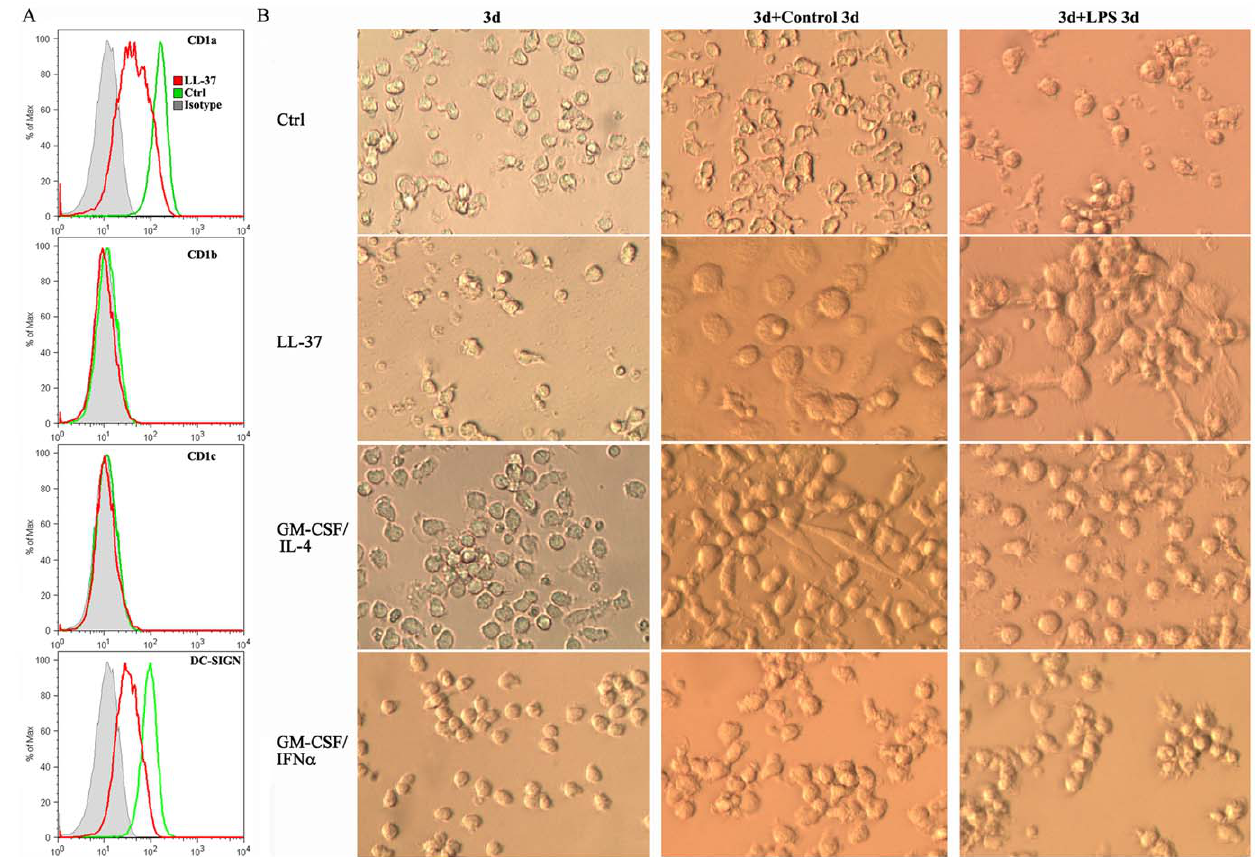
Figure 5. Monoosteophils are distinct from dendritic cells. Negatively isolated monocytes at the concentration of 1 6 10 6 /mL were incubated in the presence or absence of 5 m M LL-37, 1,000 U/mL GM-CSF/500 U/mL IL-4, GM-CSF/IFN a (both at 1,000 U/mL). A . After incubation for 6 day, LL-37-differentiated monocytes were harvested, stained with antibodies, and analyzed by flow cytometry. B . Morphology of medium-, LL-37-, GM- CSF/IL-4-, and GM-CSF/IFN a -differentiated monocytes in the presence or absence of LPS were shown by phase contrast microscopy (magnification 200 6 ). Images shown were from one of four independent experiments.